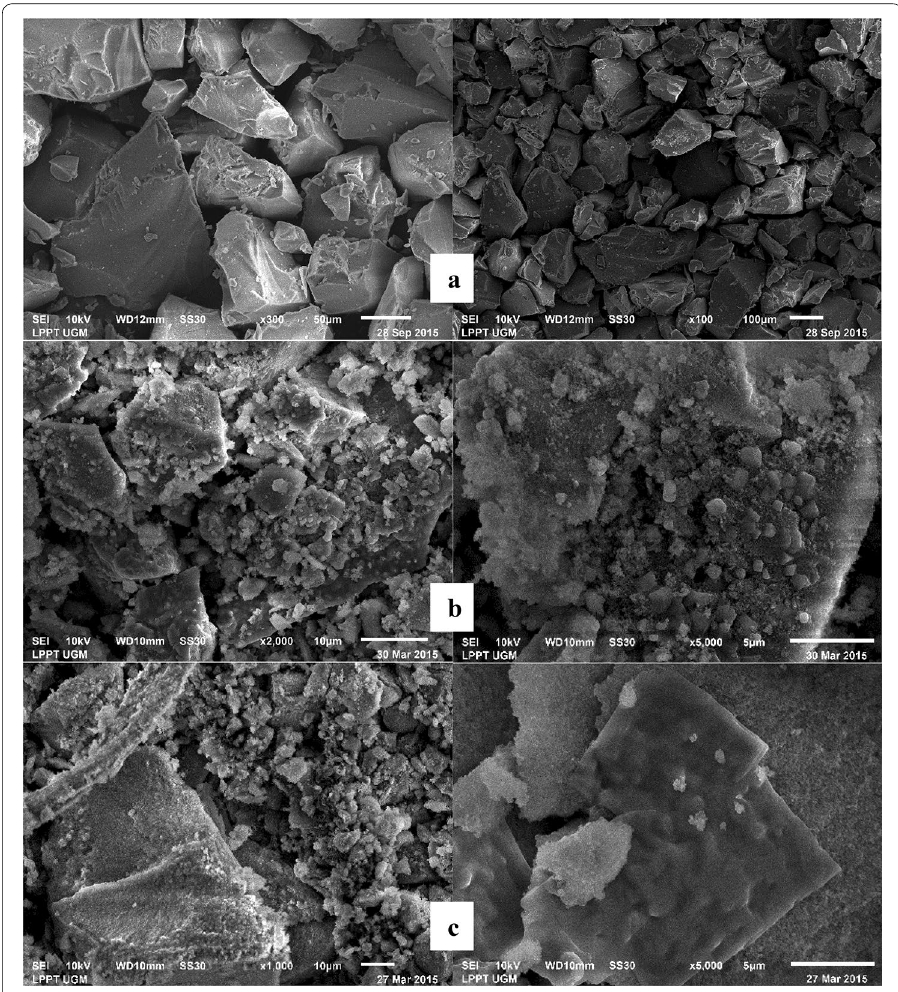
Fig. 6 SEM image of silica gel with various zoom: a initial seed and b after the precipitation process with adding seeds at pH 8 and temperature 25 ° C, c after the precipitation without adding seeds at pH 8 and temperature 25 ° C, all process conducted at 800 rpm agitation